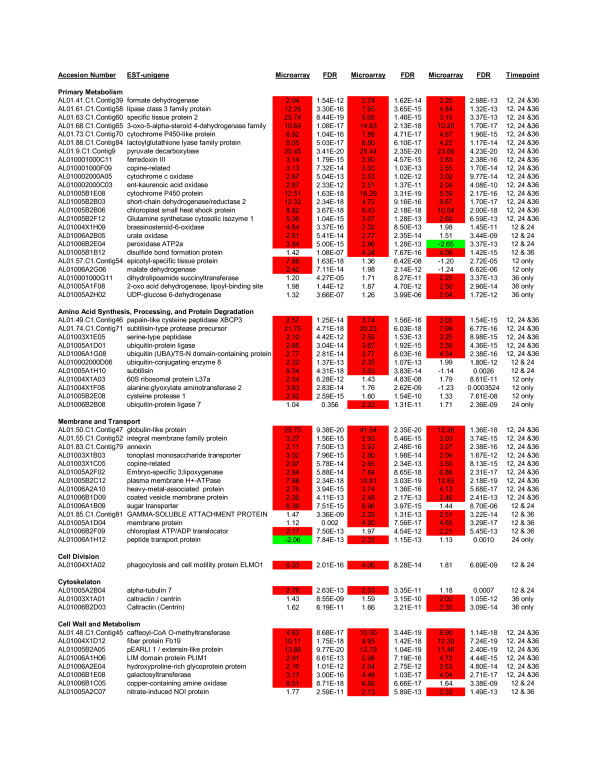
The 2x-ESTs that are differentially modulated at a specific fruit stage compared to leaf as determined by microarray analysis. One hundred and seventy-six 2x-ESTs that exhibit induction in one or more fruit types with a false discovery rate (FDR) of less than 0.05 were identified. This figure shows the first 60 of these 2x-ESTs, for the full image please see Additional File 3.